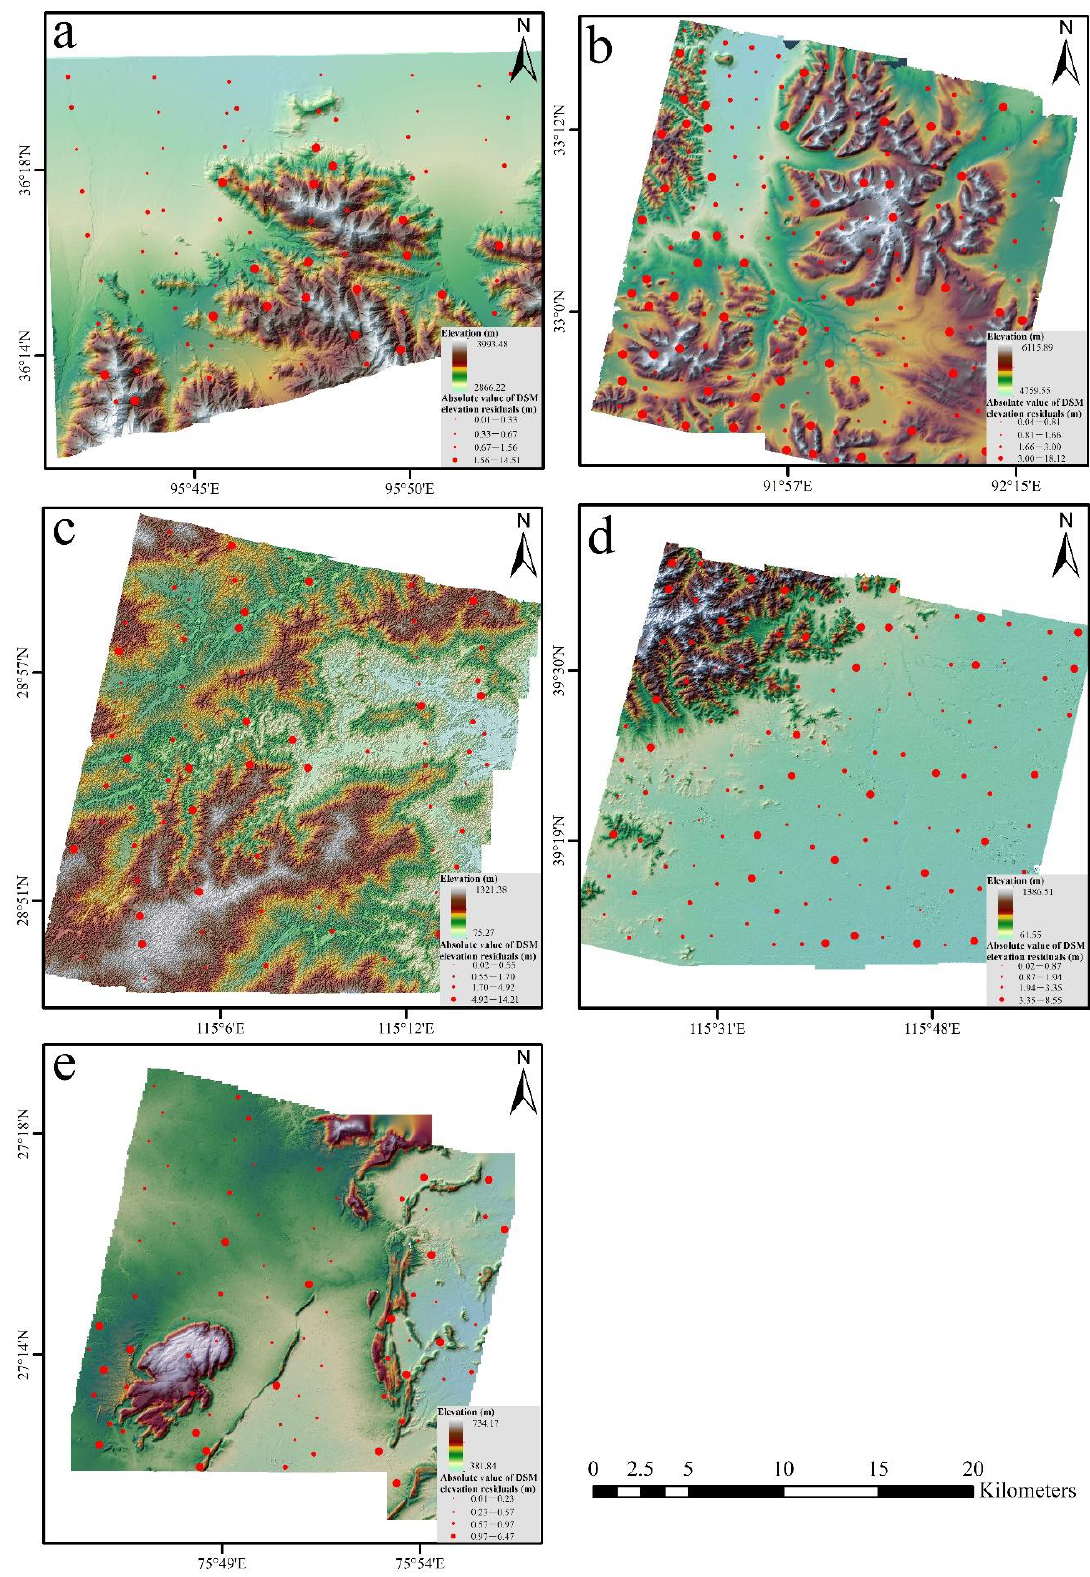
Figure 11. The spatial distribution of DSM elevation residuals after BOTS algorithm registration ( a – e ) represents the spatial distribution of the absolute value of the elevation residual after registration by the BOTS algorithm for WV2_DSM, ZY3_DSM_N32E91, GF7_DSM, ZY3_DSM_N39E115, and SV_DSM, respectively.